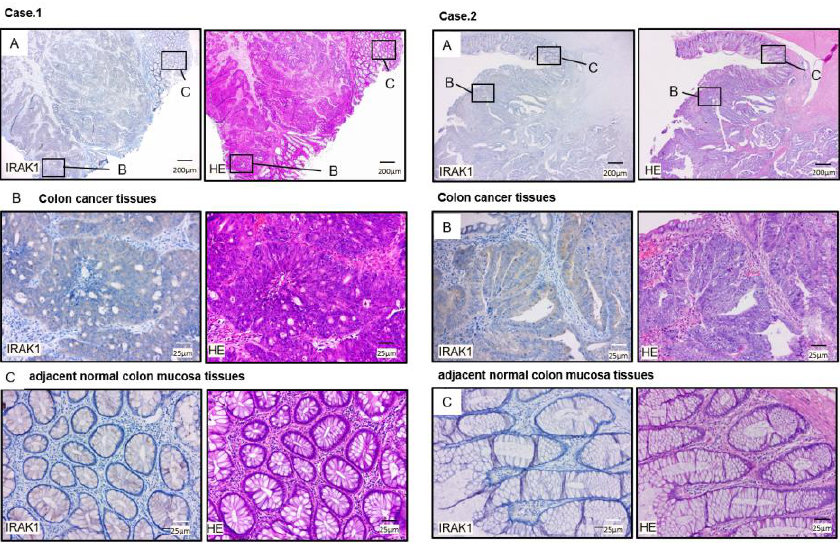
Figure 10. IRAK1 was high expression in colorectal tissues compared to adjacent normal colon tis- sues as demonstrated. The representative clinical sections of samples from case 1 (patient number 8) and case 2 (patient number 17) are shown. ( A ) Microscopic finding of immunohistochemical stain- ing for IRAK1 on the left side and hematoxylin and eosin (H&E) staining on the right side were shown (magnification, ×20). Areas in the boxes are shown magnified at colon cancer tissue ( B ) and adjacent normal colon mucosa tissue ( C ). ( B ) Immunohistochemical staining for IRAK1 H&E stain- ing in the colon cancer cell were shown (magnification, ×200). ( C ) Immunohistochemical staining for IRAK1 and H&E staining and in the normal colon epithelial cells were shown (magnification, ×200).